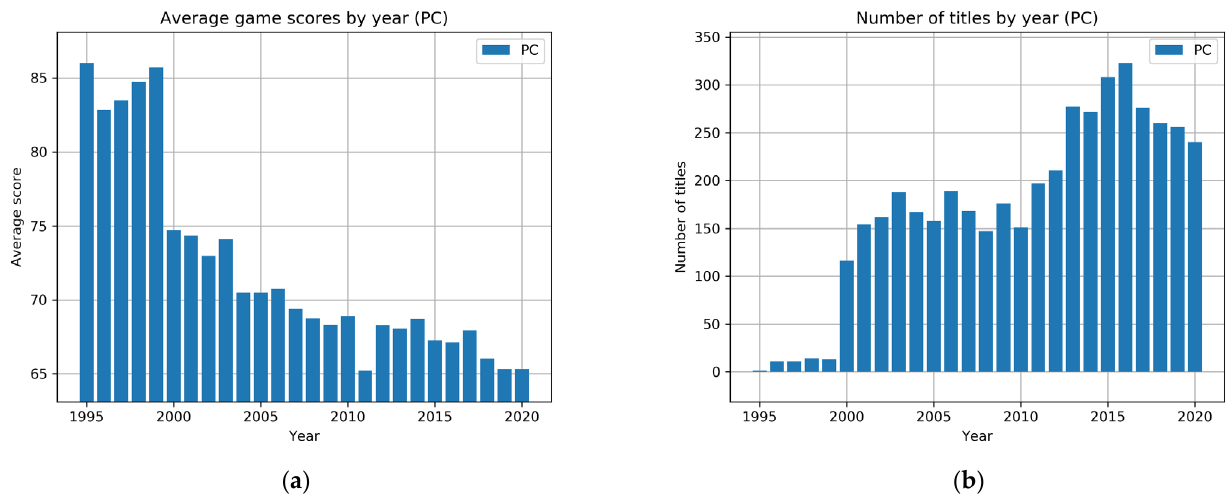
Figure 2. Evaluation of Personal Computer (PC) games statistics over time; ( a ) average user scores by year; ( b ) number of new releases by year.